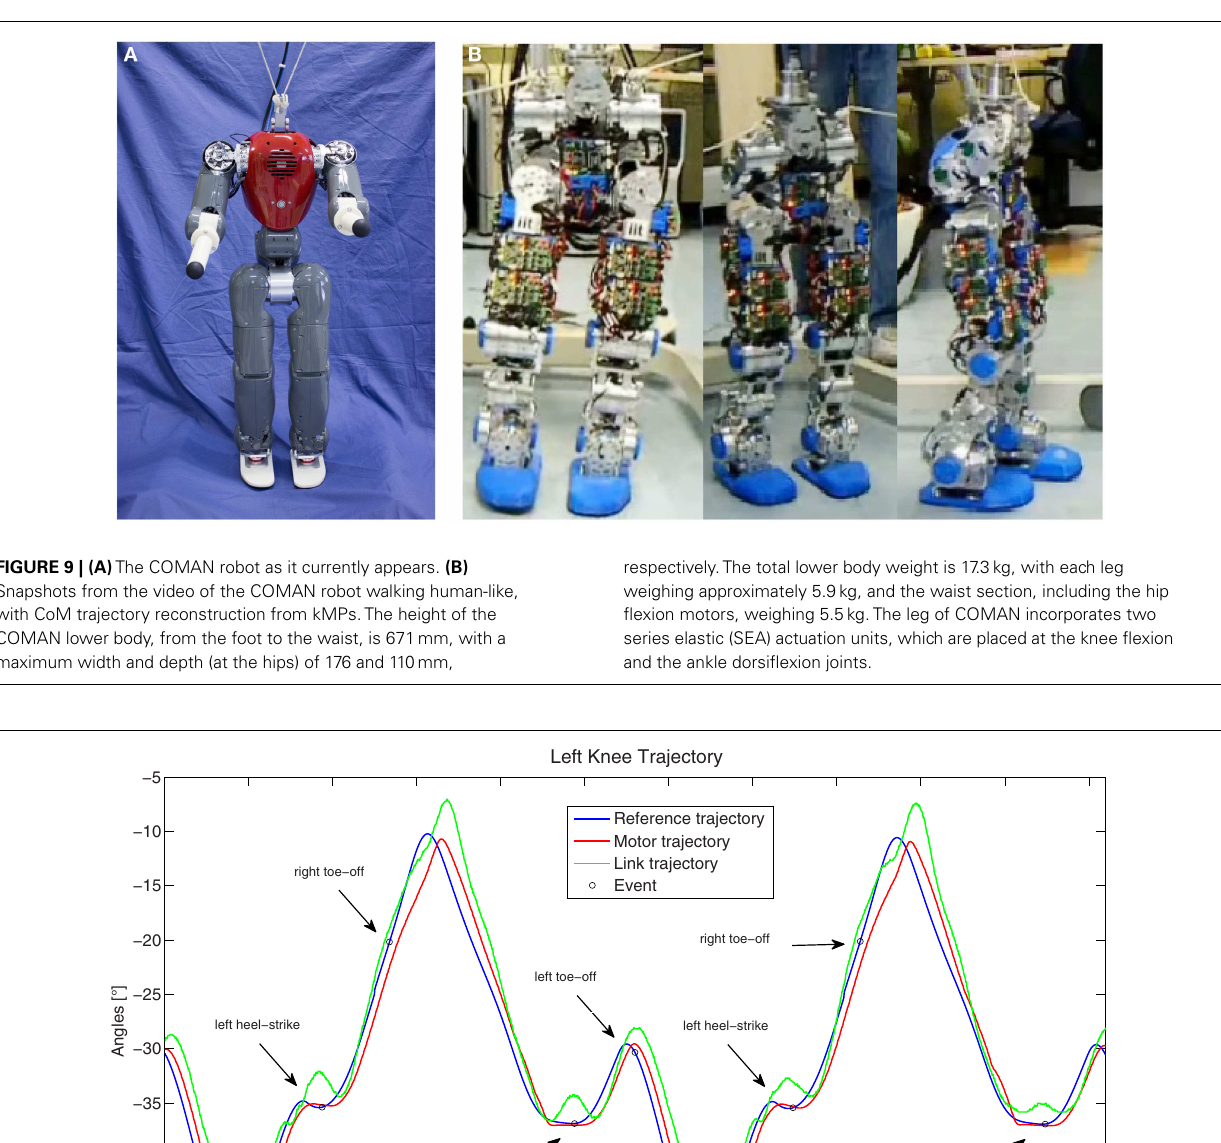
FIGURE 10 | Left knee reference, motor, and link